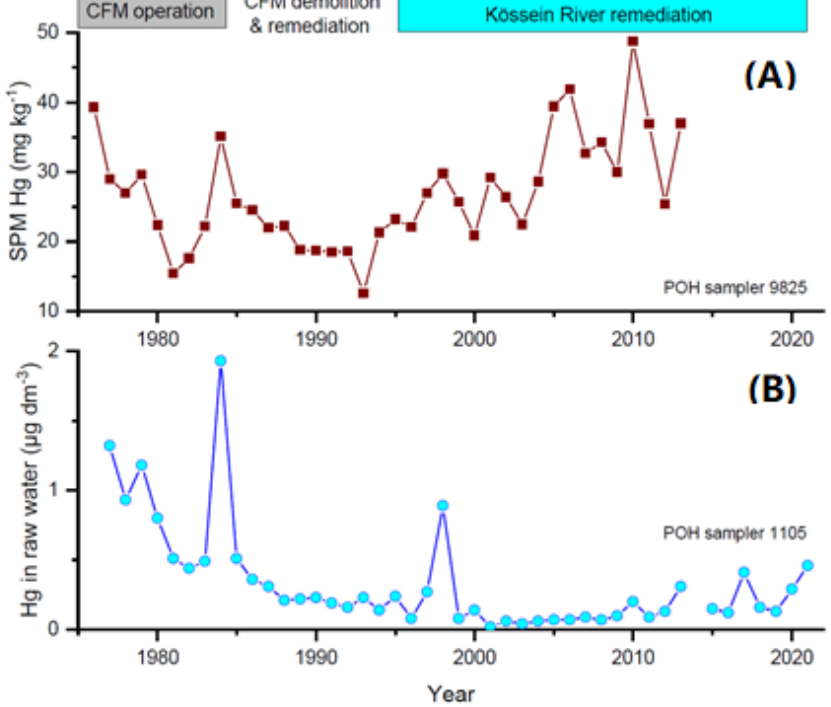
Figure 3. Temporal development of Hg concentrations in SPM ( A ) and unfiltered water ( B ) from the Röslau River near the state boundary. Annual averages are shown, positions of sampling sites are shown in Figure